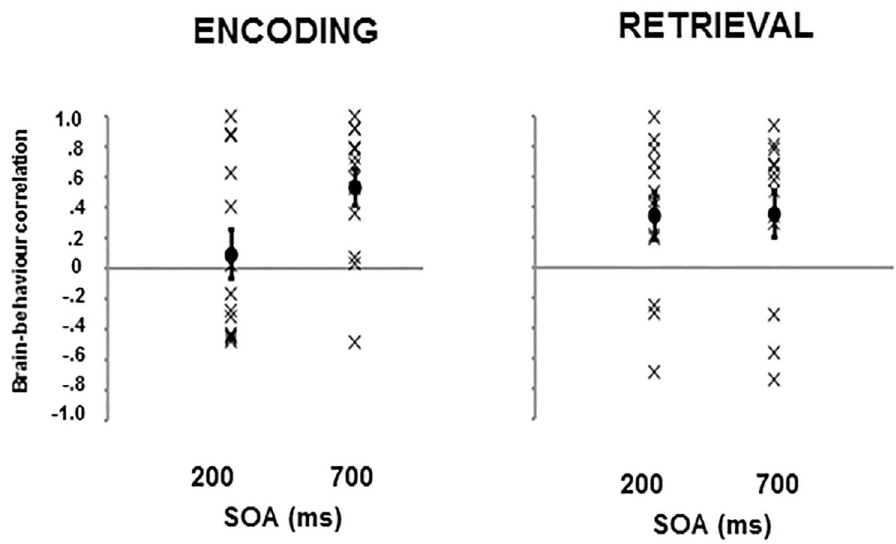
Fig 4. Correlation between ERP mean amplitude and behavioural data during encoding and retrieval stages, as a function of SOA. Individual participants’ correlationsare indicatedwith an X, conditionmeans are indicatedwith a dot. Error bars depict standard